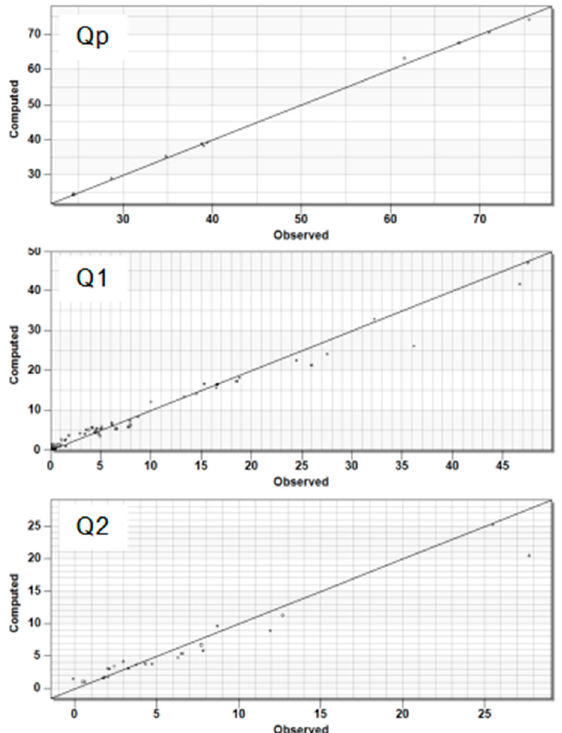
Figure 3. Plots of observed versus computed groundwater heads in steady-state model for aquifers Qp, Q1, and Q2.